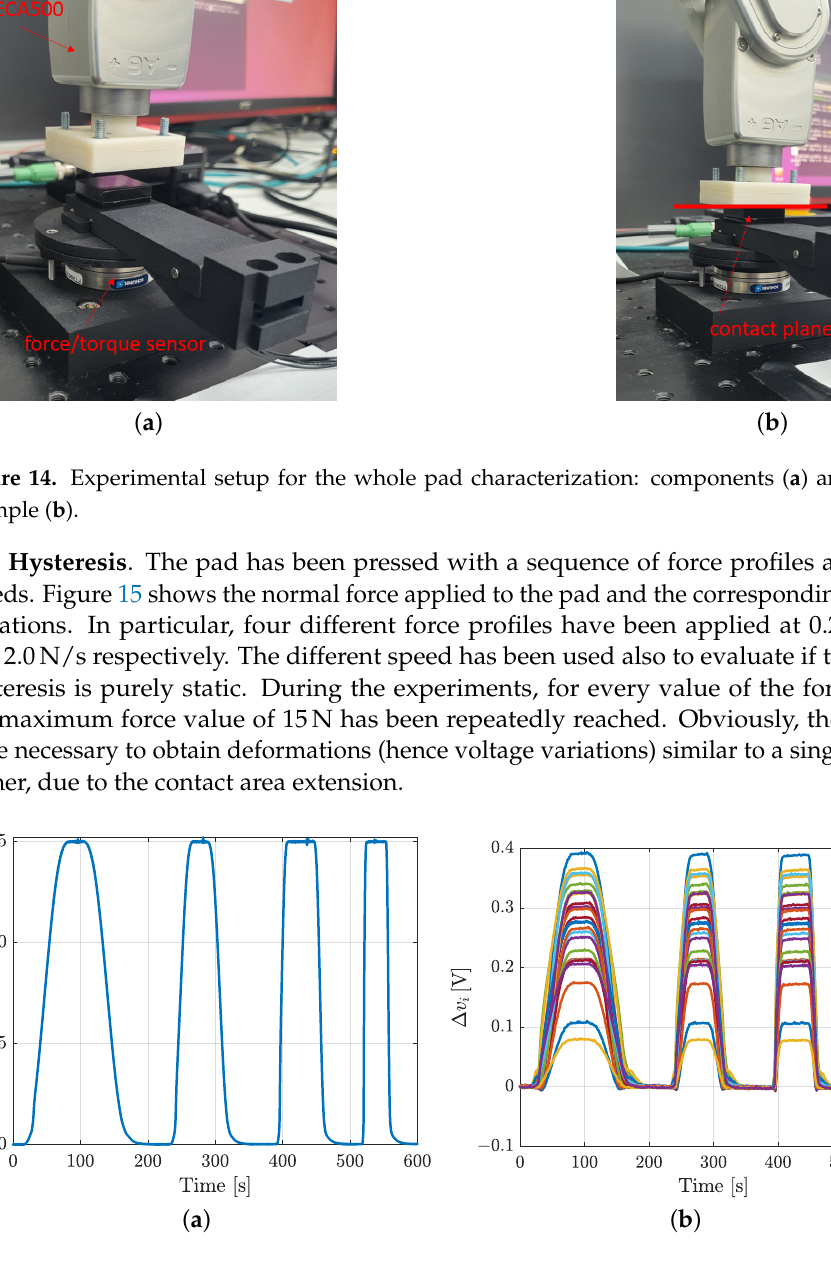
Figure 15. Hysteresis experiment for the whole pad characterization: force profile ( a ) used to stimulate the pad and corresponding voltage variations ( b